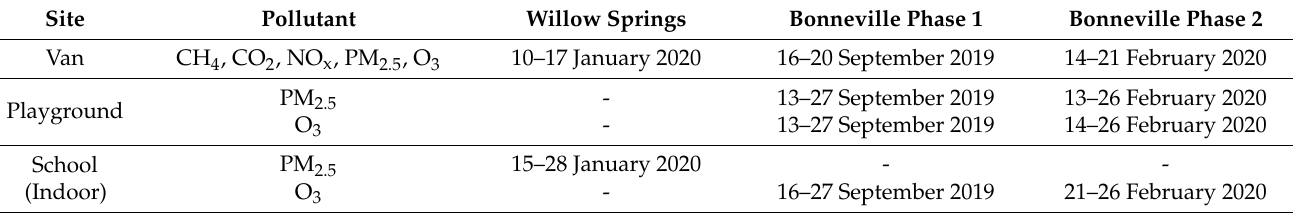
Table 1. Campaign timelines including sensor availability.